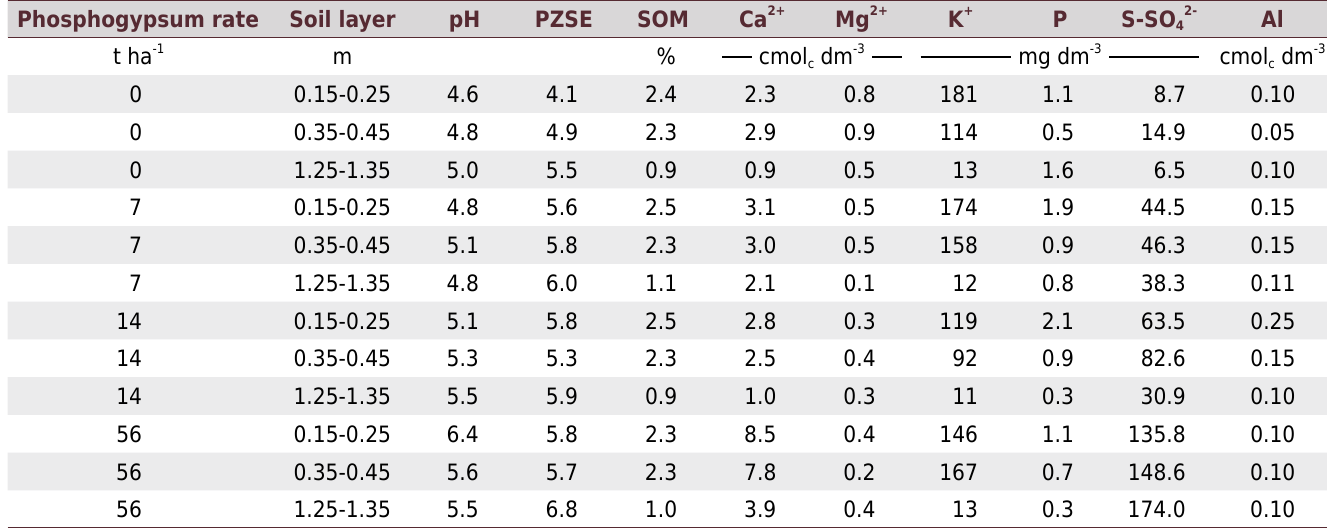
Table 1. Chemical properties of the studied soil samples Phosphogypsum rate Soil layer